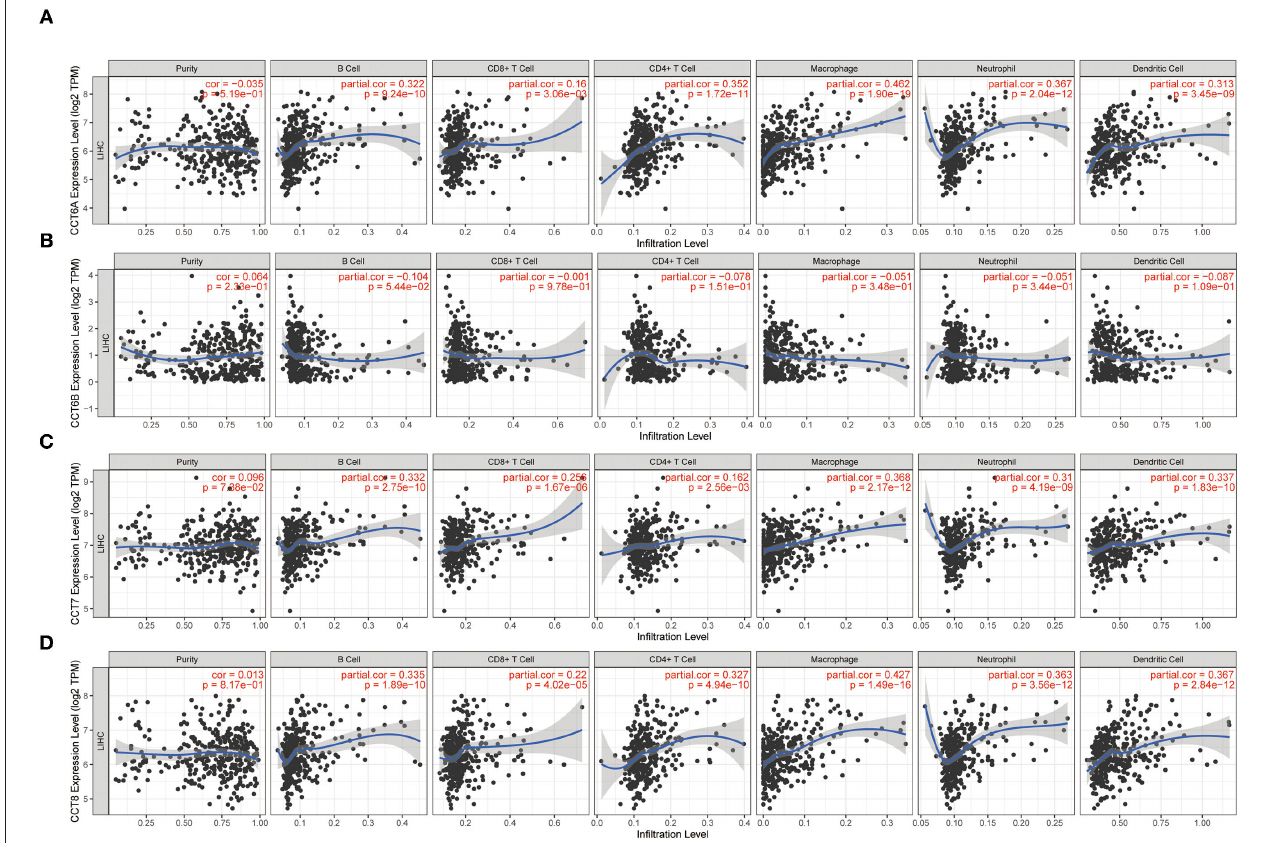
FIGURE 6 | Correlation of immune cell infiltration with CCT6A (A) , CCT6B (B) , CCT7 (C) , CCT8 (D)